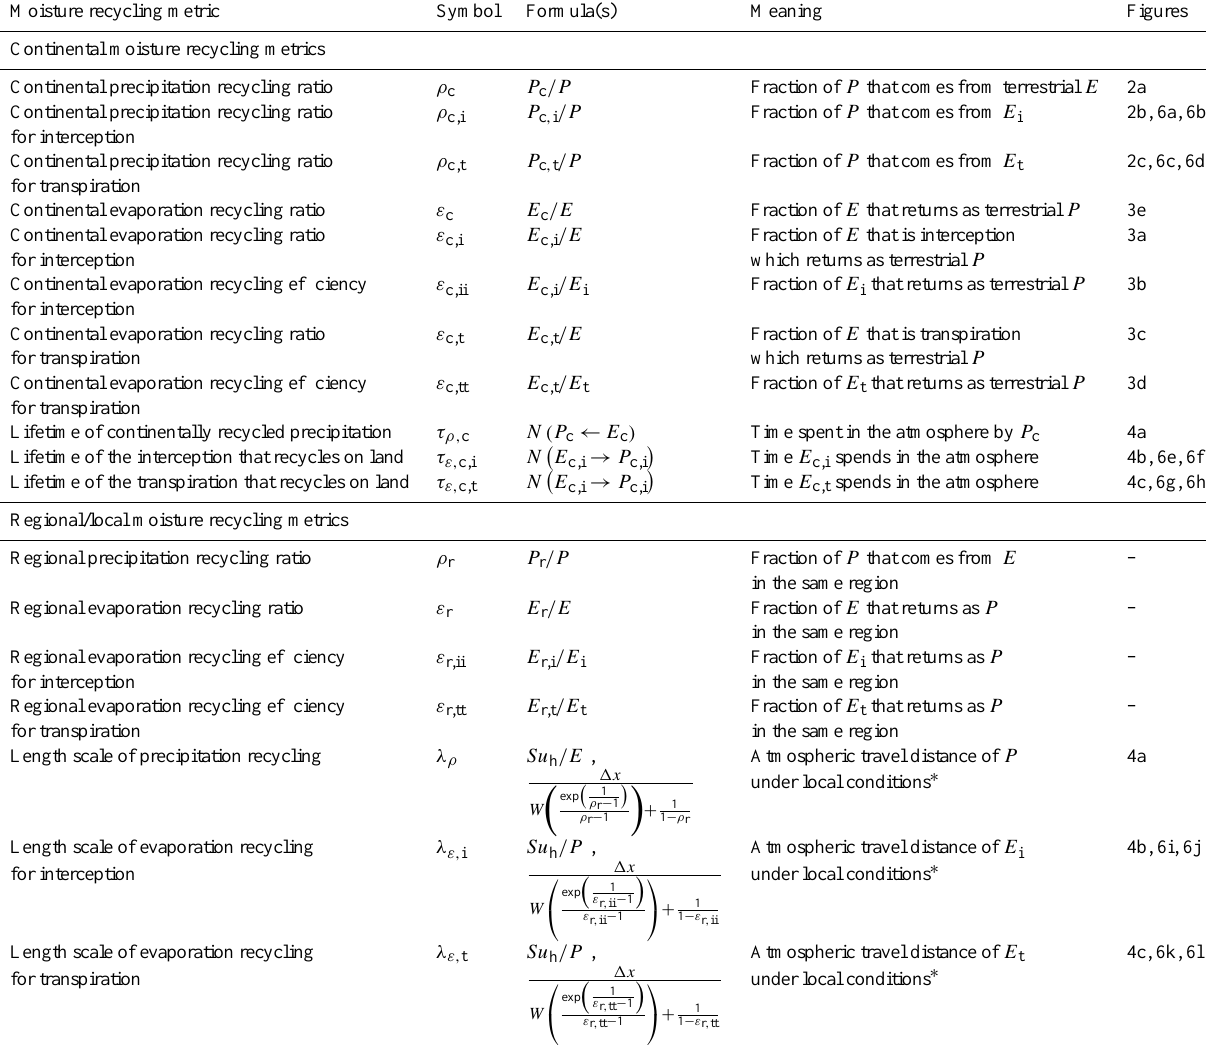
Table 1. Overview of moisture recycling metrics used in this study. Moisture recycling